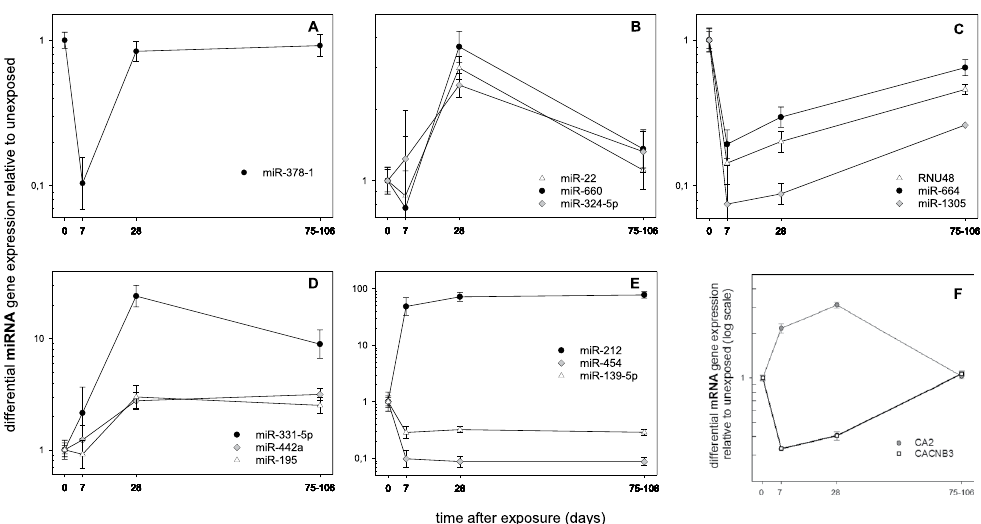
Figure 2. Differential gene expression changes over time are depicted for miRNAs ( A–E ) and mRNAs ( F ). Up to three examples for genes either differentially expressed only on days 7 ( A ) or 28 ( B ) and on two consecutive days (7–28, ( C ) or 28–75, ( D ) or over the whole period of time ( E ) are shown. Candidate mRNAs differentially expressed on days 7–28 are shown in panel F . Symbols represent geometric mean values and error bars reflect the standard error of mean. Numbers of measurements per group are shown in Supplement Table